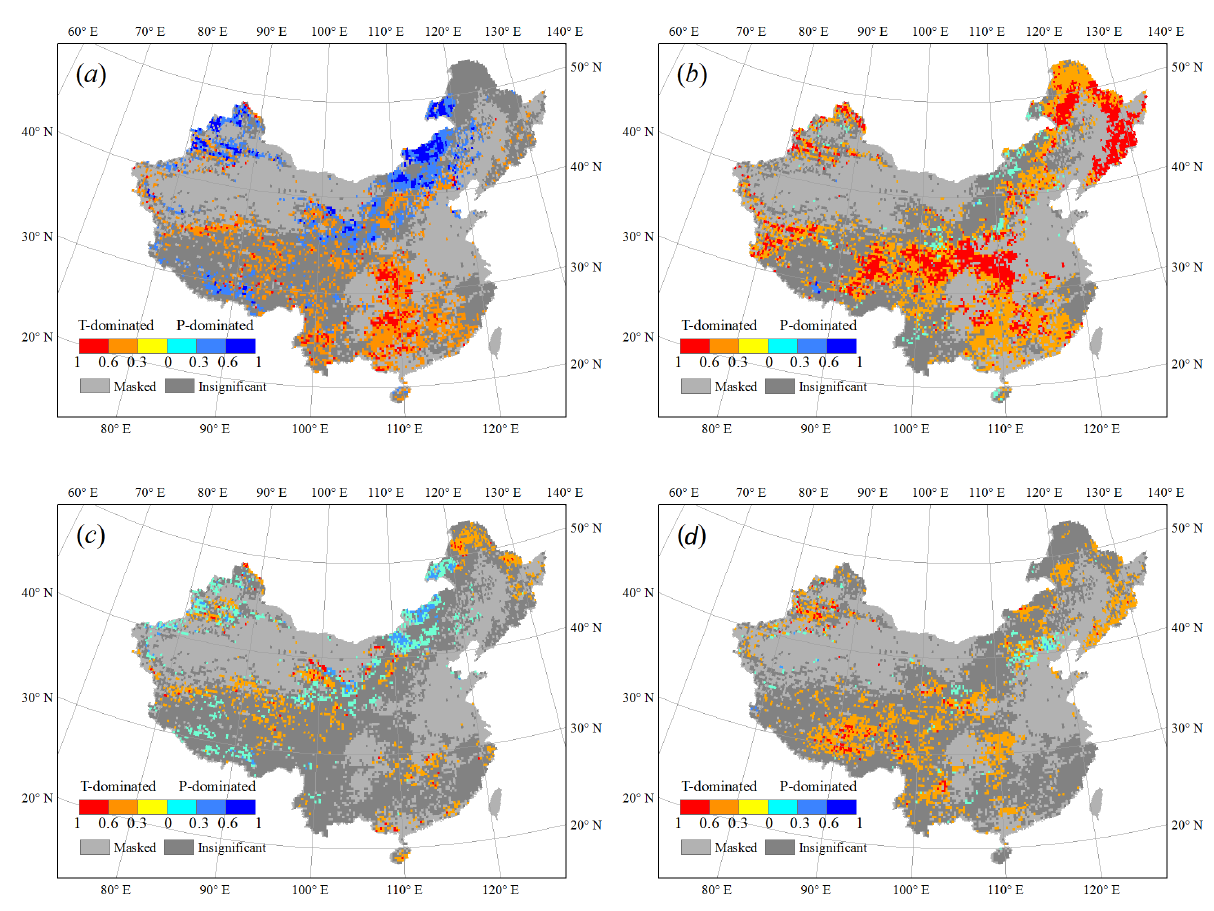
Figure 9. Spatial distribution of dominant climatic drivers in ( a ) growing season; ( b ) spring; ( c ) summer and ( d ) autumn. Pixels in red are temperature-dominated and pixels in blue are precipitation-dominated. Darker color represents larger relative effect. Light gray pixels are masked out according to land cover and dark gray pixels show insignificant